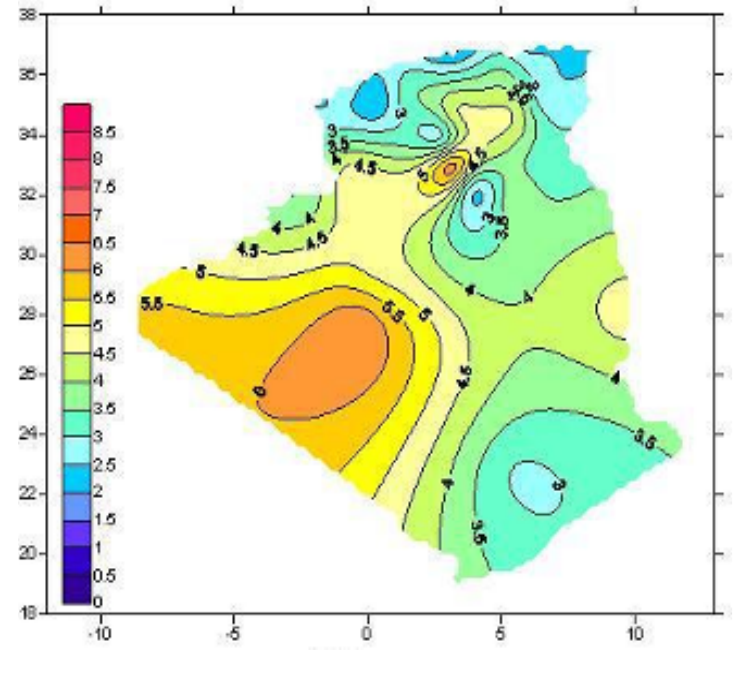
Figure 2. Wind fields Algeria chart at 10 m altitudes on the surface of the Earth [5] Table 4. Algeria total wind farm installed